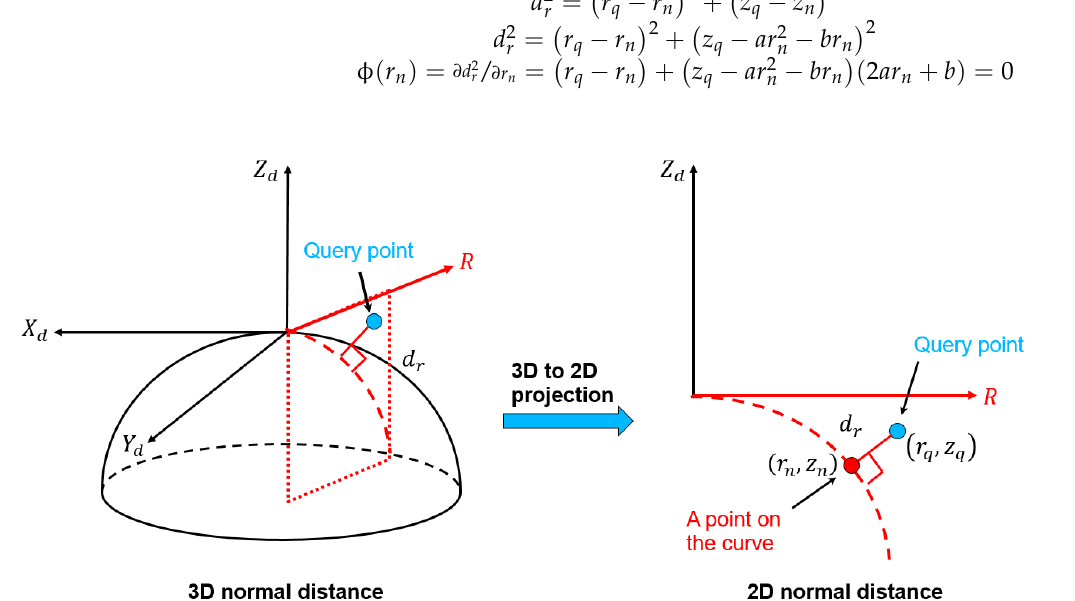
Figure 15. Schematic diagram of point-to-quadratic surface distance ( left ) and its 2D projection ( right ).